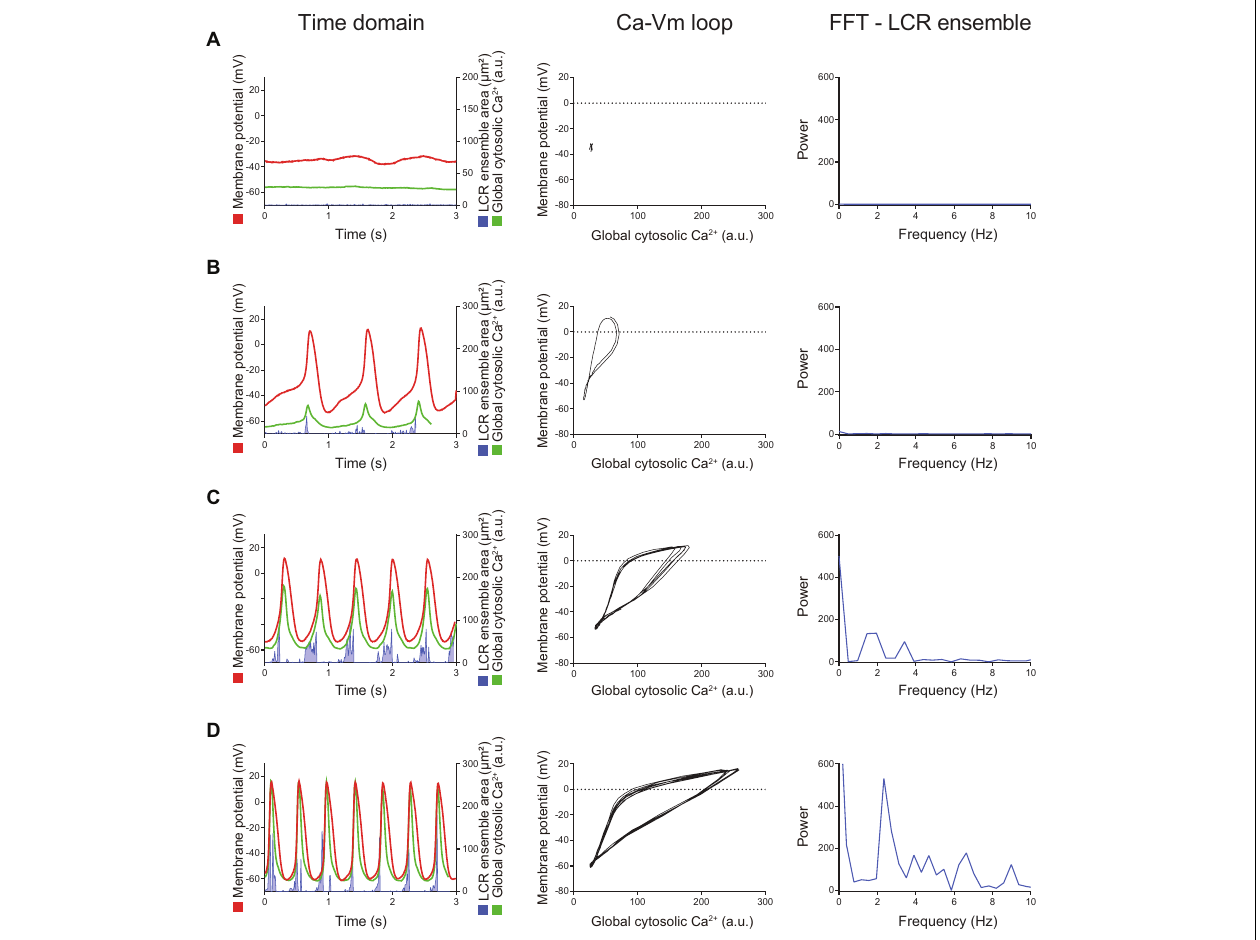
FIGURE 5 | Later stage of the β -AR stimulation-induced AP induction sequence observed in other SANC that was initially dormant at baseline. Time domain (left), Ca 2 + -Vm loop (middle) and FFT of Ca 2 + signals (right) during the baseline dormancy (A) , early stages (B,C) , and steady state (D) of AP induction in response to β -AR stimulation. The Ca-Vm loop evolves to expand as the AP cycle length shortens in response to β -AR